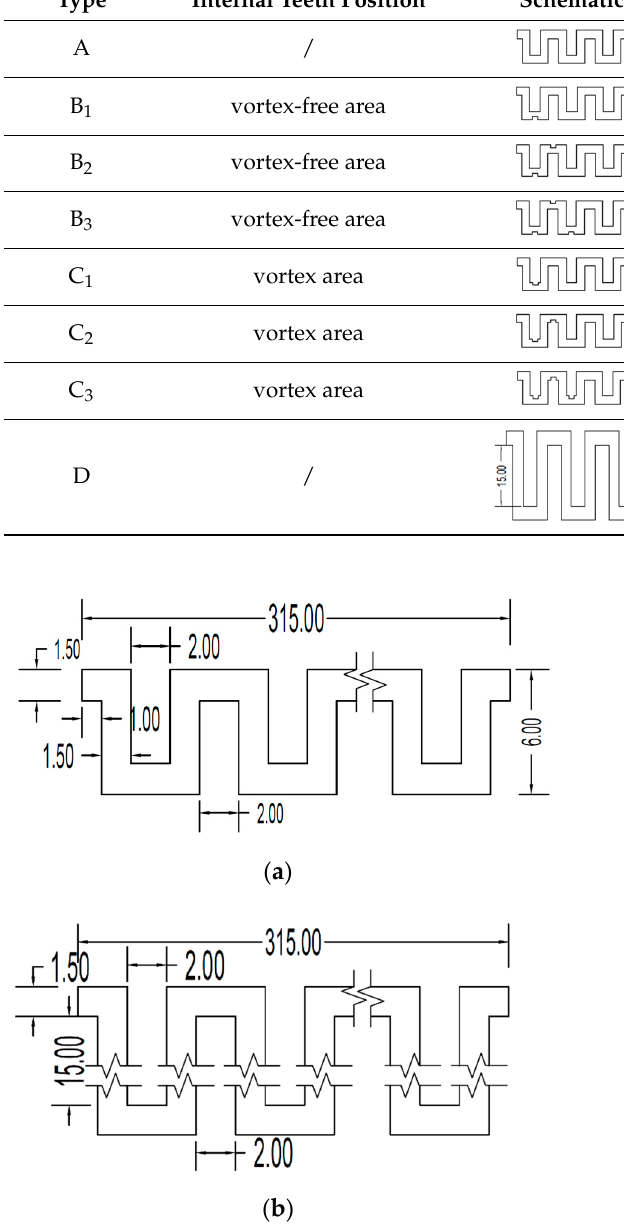
Table 1. The structure and parameters of the emitters.